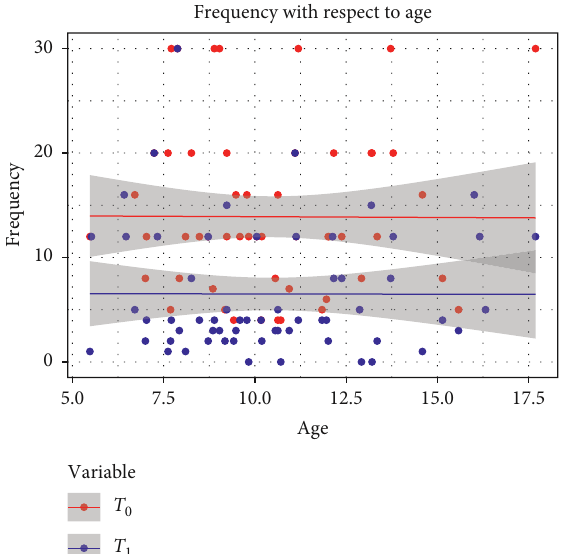
Figure 3: Comparison of intensity of migraine attacks before and after 12 weeks of treatment with umPEA.